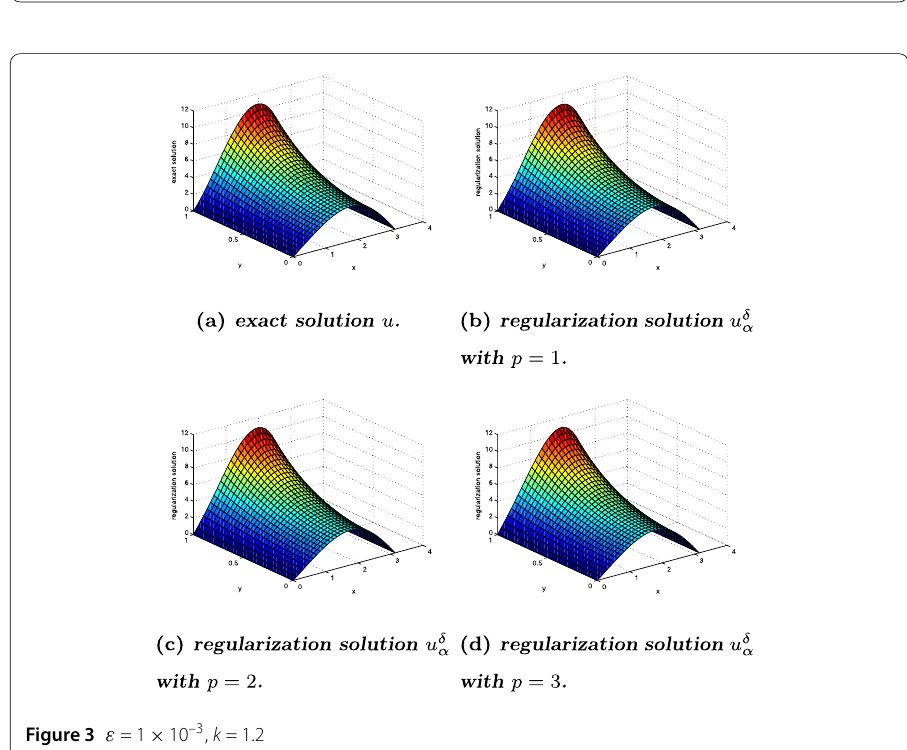
Figure 3 ε = 1 × 10 –3 , k =